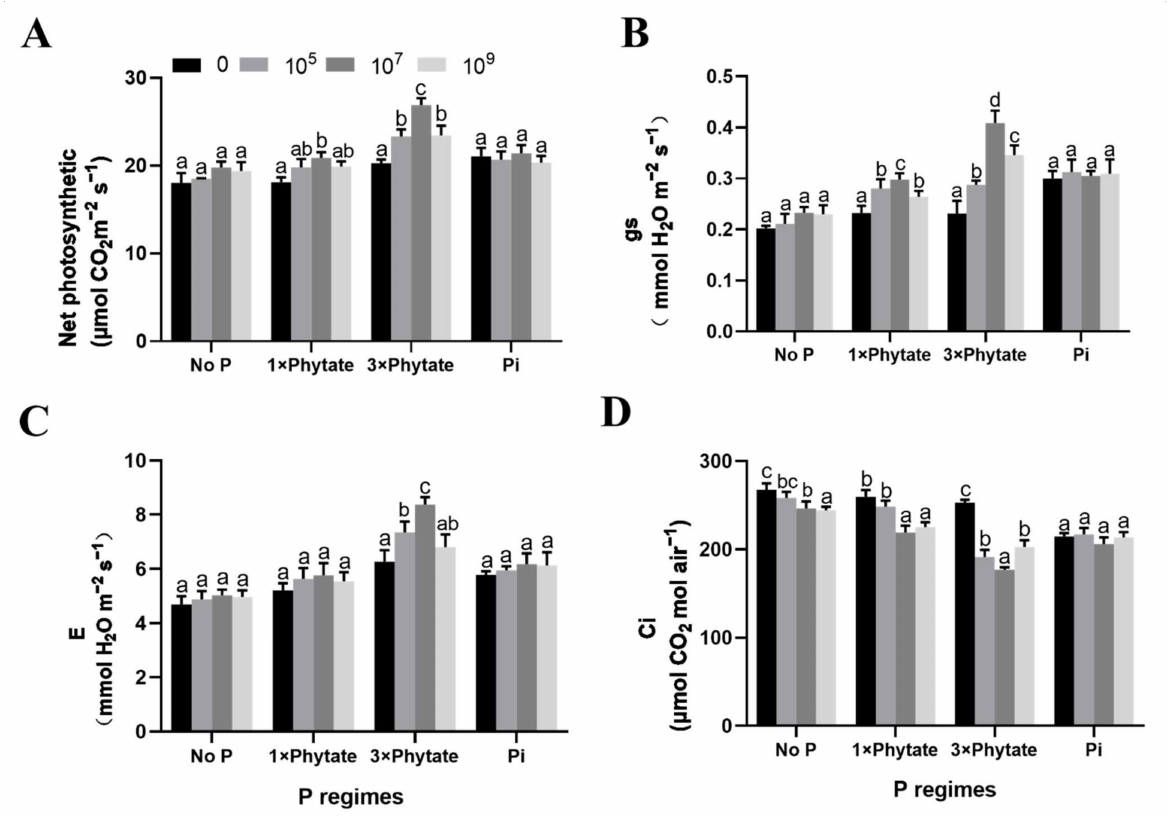
Figure 4. Effect of inoculation with three different concentrations of R. aquatilis JZ-GX1 under four different P regimes on the photosynthetic parameters of corn seedlings. ( A ) Net photosynthetic rate (Pn), ( B ) Stomatal conductance (gs), ( C ) Transpiration rate (E), ( D ) Intercellular CO 2 concentration (Ci). Different letters indicate statistically significant differ- ences ( p < 0.05) among treatments according to the least significant difference